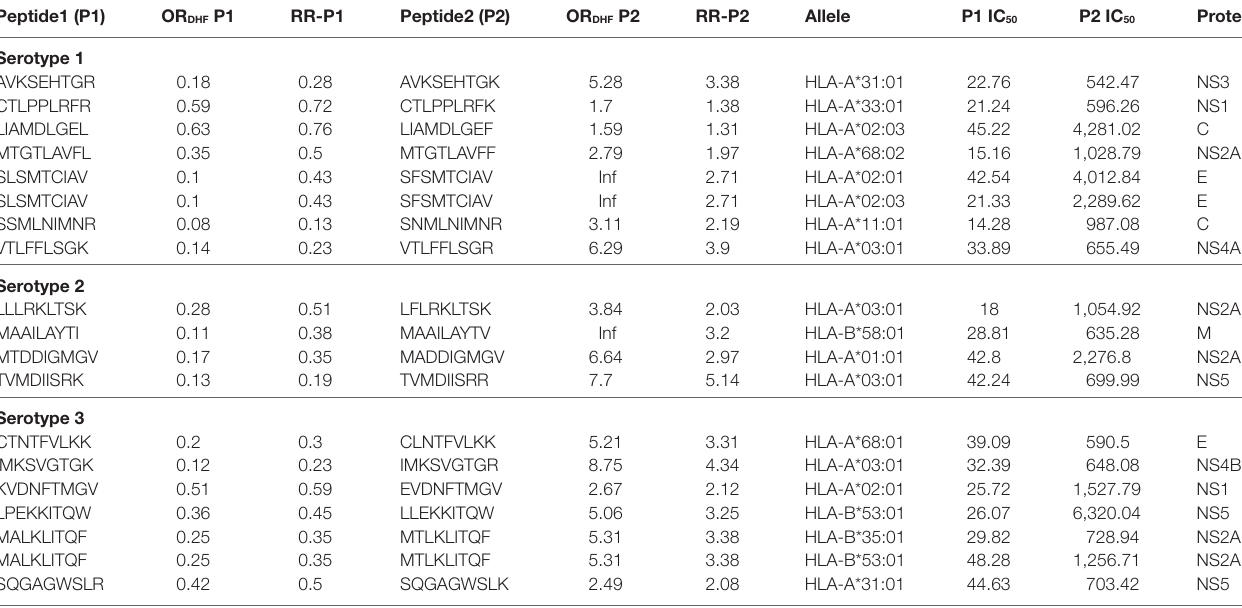
TaBle 2 | HLA-I binding single amino acid variants present differentially in dengue fever and dengue hemorrhagic fever (DHF) primary infection among different serotypes. Peptide1 (P1) Or DhF P1 rr-P1 Protein serotype 1